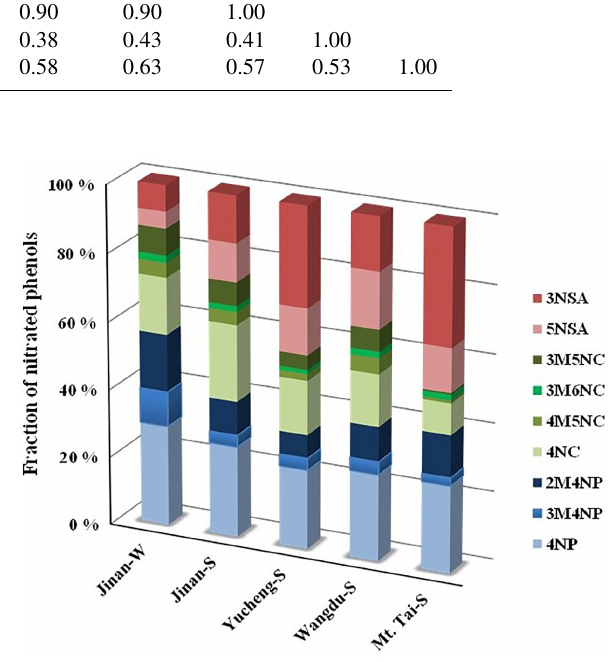
Figure 2. Fractions of individual nitrated phenols in the total partic- ulate nitrated phenols at four sampling sites in wintertime and sum- mertime. W represents the winter measurement and S represents the summer